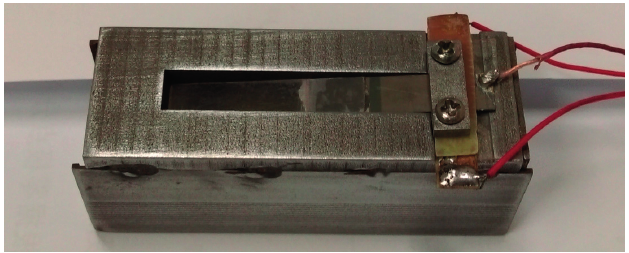
Figure 1. A prototype of the wind energy harvester with a resonant cavity.